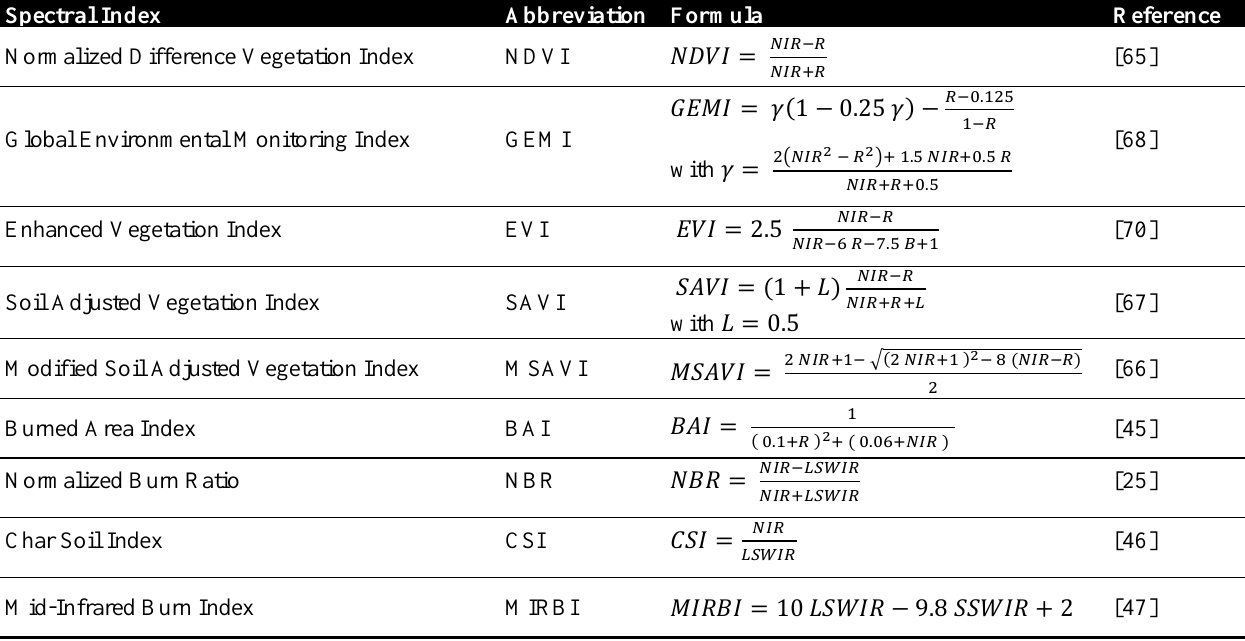
Table 2. Spectral indices tested in this study. See text for wavelength